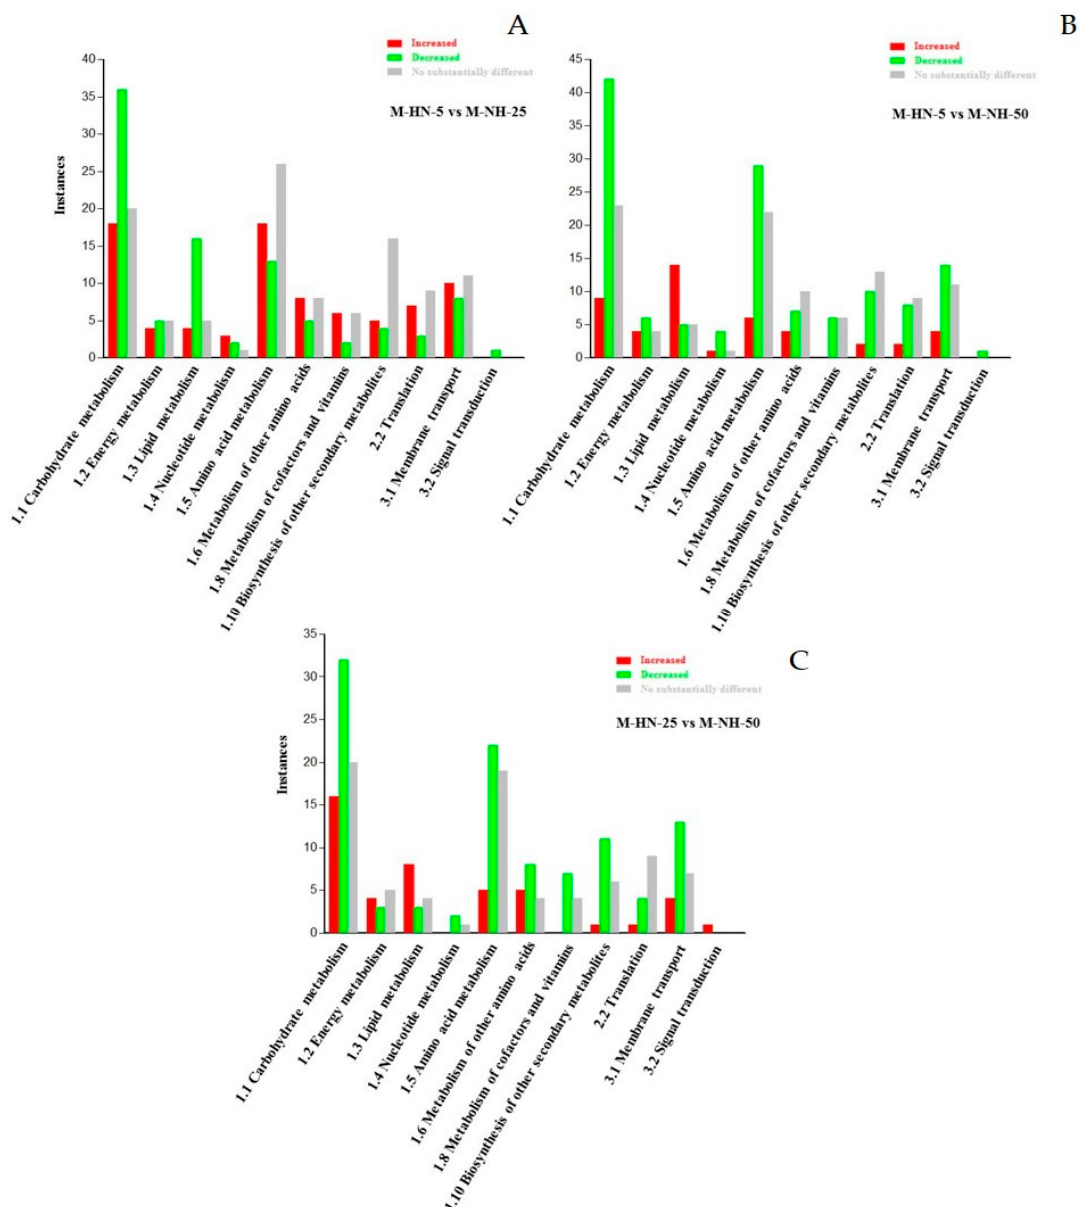
Figure 5. Fluctuations of the stamnagathi metabolic functions following treatments with NH 4 / total-N fraction (5% vs. 25% ( A ), 5% vs. 50% ( B ), and 25% vs. 50% ( C ) in the nutrient solution supplied to the montane ecotype of stamnagathi grown in perlite bags. The y -axis corresponds to instances, since each metabolite can be involved in multiple pathways. The first bar (red) corresponds to metabolites whose concentration increased in response to the treatment, the second (green) to those decreased, and the third (gray) to those that were not substantially altered. The coding system of KEGG was adopted. The levels of most metabolites that belong to fatty acids were detected in higher levels in the montane ecotype compared to that of the coastal area (Figure S2A). On the other hand, the level of N supply did not substantially alter the biosynthesis of carbohydrates, carboxylic acids, and fatty acids, since the majority of the metabolites of these chemical groups were not affected (Figure S2A). An